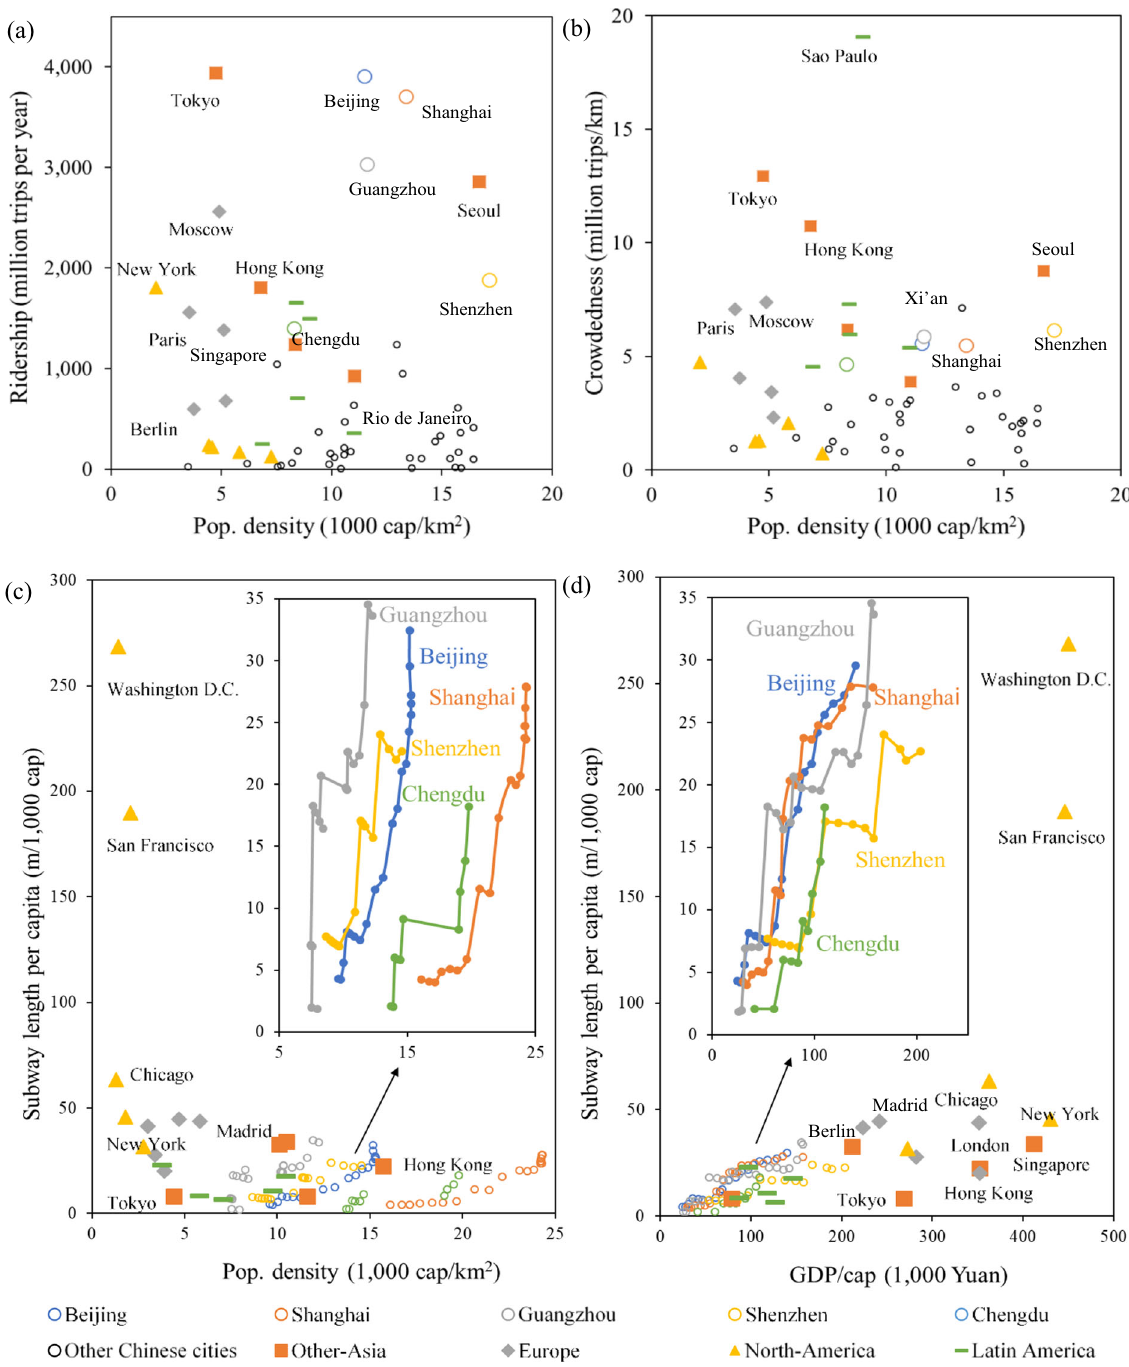
Fig. 3 Relationship of between subway ridership, crowdedness, and length with key socioeconomic factors in the selected 25 cities with the world ’ s busiest subway lines. ( a ) Subway ridership and population density; ( b ) Subway crowdedness and population density; ( c ) Subway length per capita and population density; and ( d ) Subway length per capita and GDP per capita. The fi ve selected Chinese cities are shown in the inner fi gures of ( c ) and ( d ), due to available historical